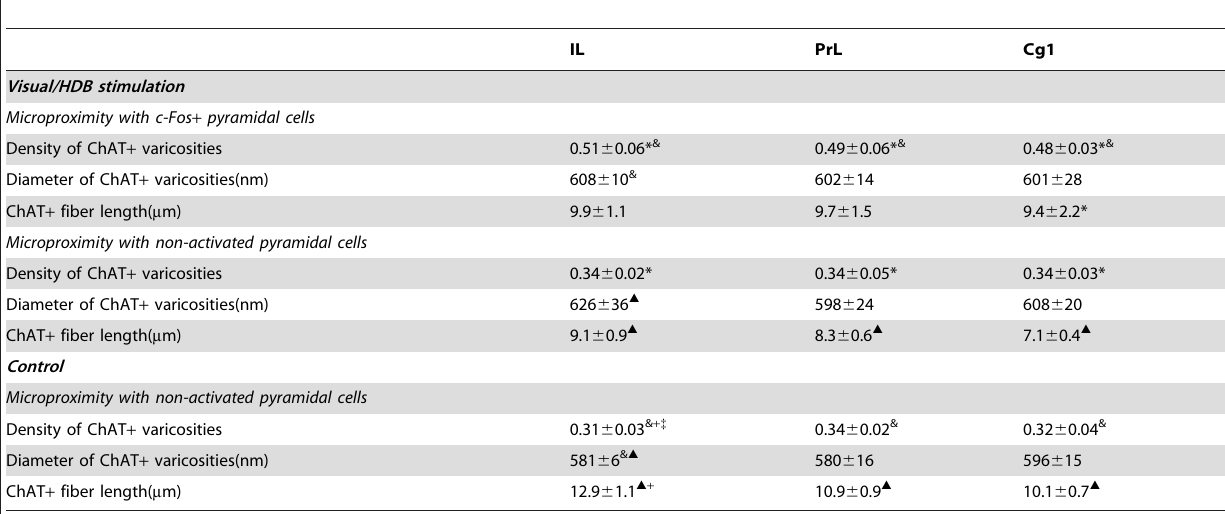
Table 4. Density and diameter of ChAT + varicosities and length of ChAT + fiber segments within microproximity of Pyramidal cells in Layer V of mPFC.